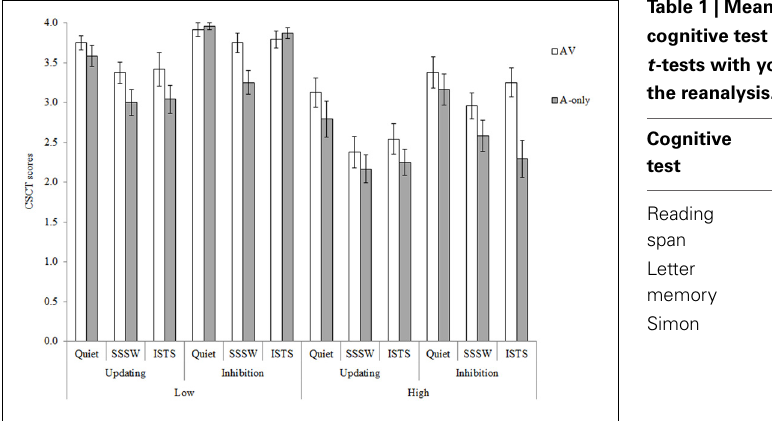
FIGURE 2 | Mean CSCT raw scores for the AV (unfilled bars) and A-only (filled bars) modalities of presentation in the high and low memory load conditions of the updating and inhibition tasks in the three noise conditions. Error bars represent standard